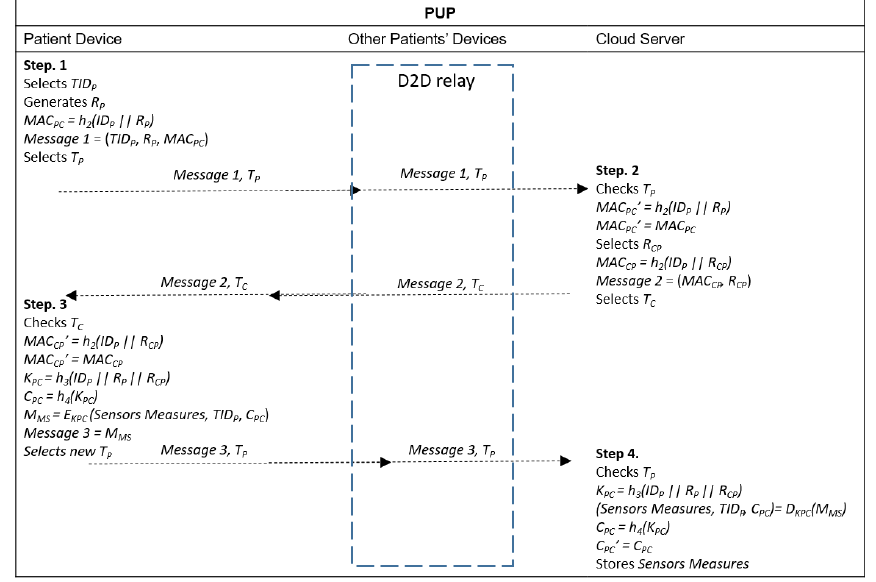
Figure 4. Message exchange in PUP when device-to-device (D2D) communication is adopted to reach the 3GPP infrastructure and the cloud server.